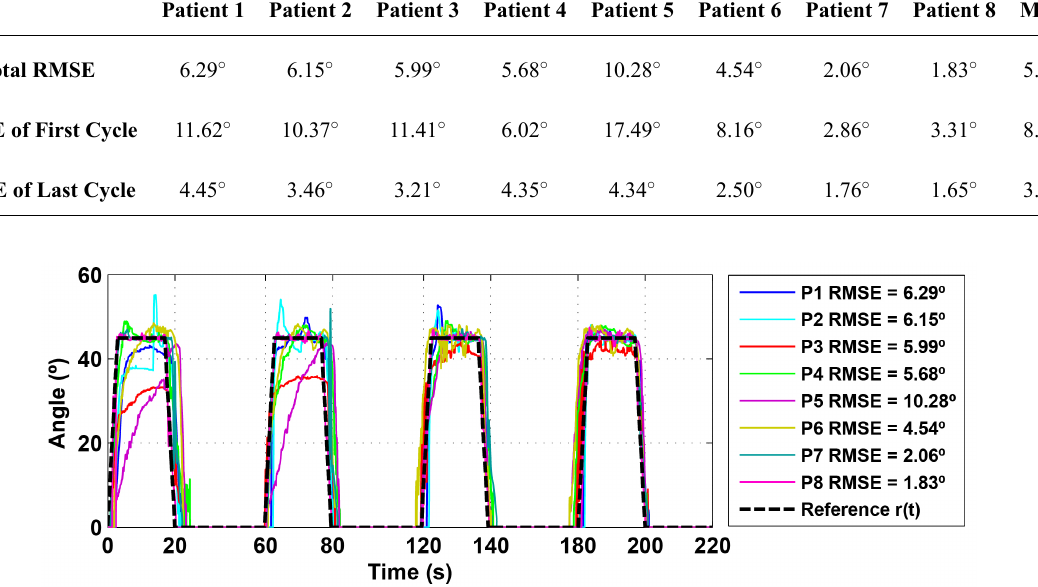
Root-Mean-Square Error (RMSE) obtained for stroke patients.